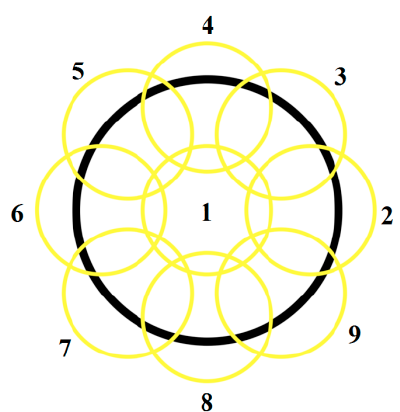
Figure 13. A diagram of partially overlapping zones of curing sample.